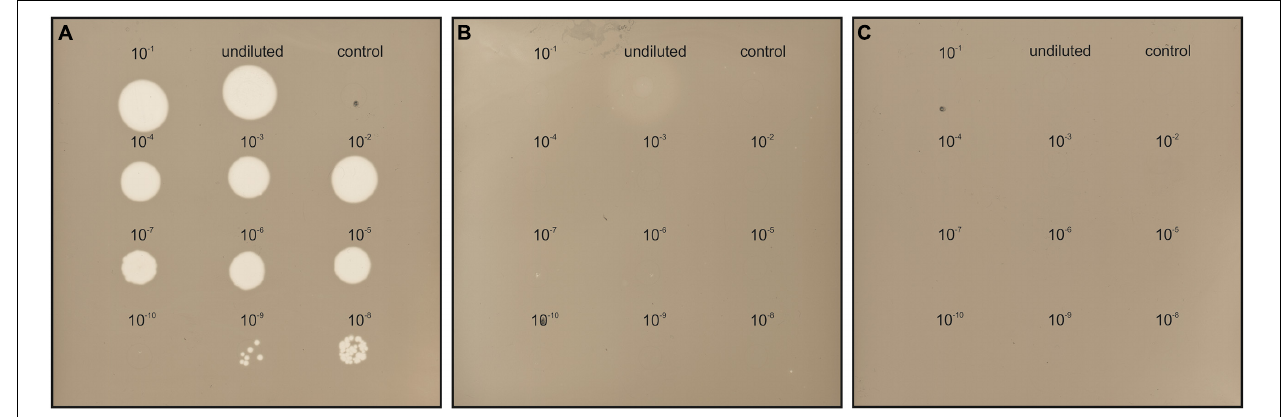
FIGURE 2 | HFTV1 susceptibility of Haloferax strains by spot-on-lawn assay. Spot-on-lawn assay conducted with lawns of (A) Hfx. gibbonsii LR2-5, (B) Hfx. gibbonsii Ma2.38, and (C) Haloferax volcanii H26. Different dilutions of HFTV1 lysate (undiluted 5 × 10 11 PFU/mL) were spotted on the host lawns and incubated for 3 days. Control spots were prepared with medium.